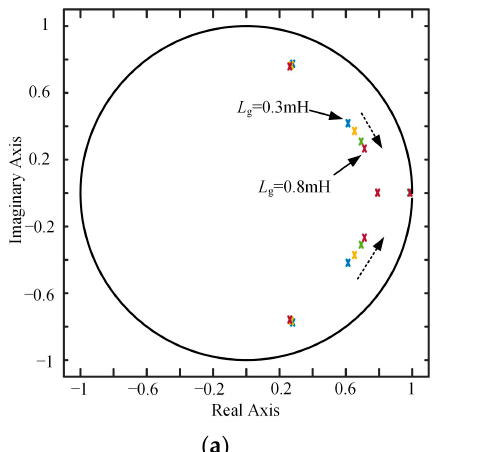
12 of 18 and || H (e j ω T s )|| ∞ = 1.9577, which does not satisfy the inequality Equation (17). As a result, the system is unstable. Case C (T d = T s ) : In this case, a pair of unstable poles of H ( z ) is shown in Figure 9a. As a result, even though the locus of | H (e j ω T s )| is inside the unit circle, the system is still not stable. In summary, the proposed current control system with the H ∞ RC is stable and has a reasonable stability margin when T d = 0.5 T s . ( a ) ( b ) Figure 9. Stability analysis for the system with variable T d ( T d = mT s , 0 ≤ m ≤ 1). ( a ) Pole map of H ( z ); and ( b ) locus of the vector | H ( e j ω T s )|. 4.4. Stability Analysis Considering the Variation of Grid-Impedance When an LCL-type inverter is connected to the grid, the stability of the system is affected by the equivalent grid-impedance. In general, the grid-impedance is considered in series with the grid side inductor L g . While the resistance of the grid-impedance can provide passive damping to the LCL filter, the inductance can decrease the resonance frequency of the LCL filter and makes the control system unstable [26]. Therefore, the proposed controller should be sufficiently robust against the variation of the inductance of grid-impedance. The grid-impedance is considered as pure inductance for the worst case and is represented by the equivalent series inductor at the low-voltage side of the grid-connected transformer. Thus, when the power rating is 10 kW, the voltage rating is 130 V, and the equivalent inductance is considered up to 10% PU. As a result, the value of L g varies from 0.3 to 0.8 mH.